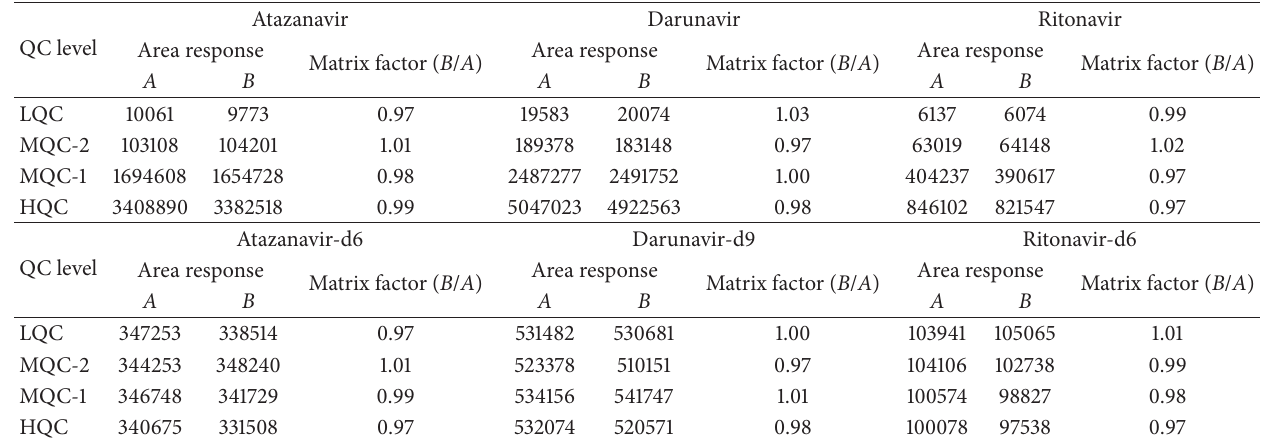
Table 4: Matrix factor for atazanavir, darunavir, and